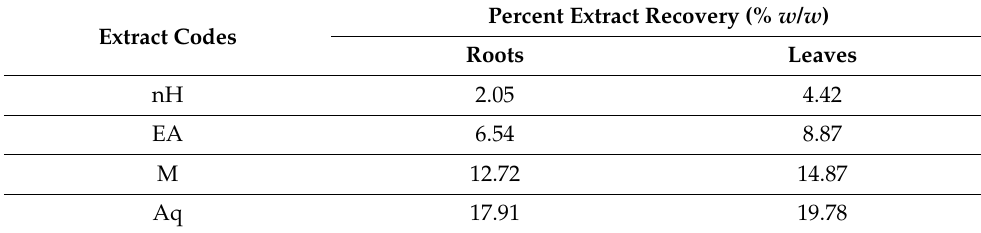
Table 1. Extract recovery of different parts of W. somnifera